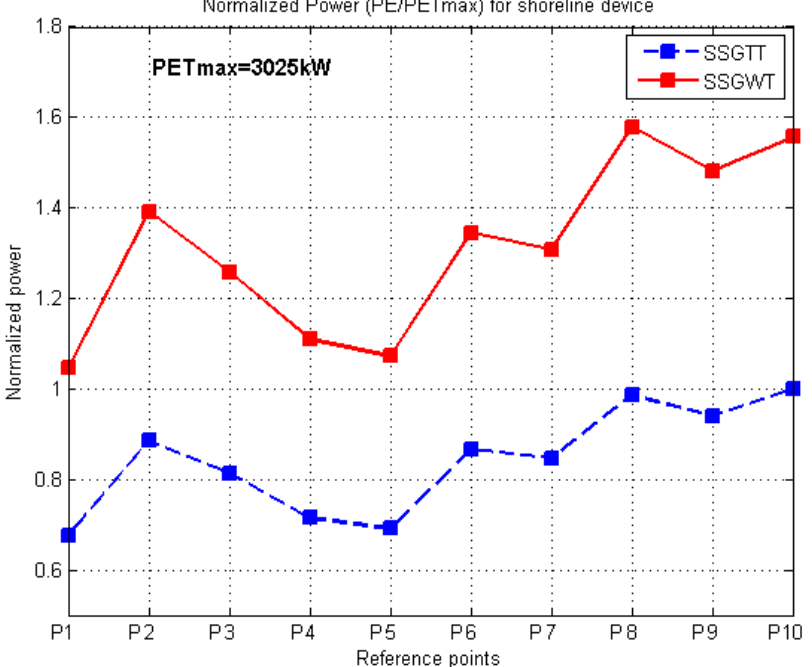
Figure 8. Normalized electric power for the SSG shoreline device in the nearshore reference points (from north to south) corresponding to total (TT) and winter time (WT),